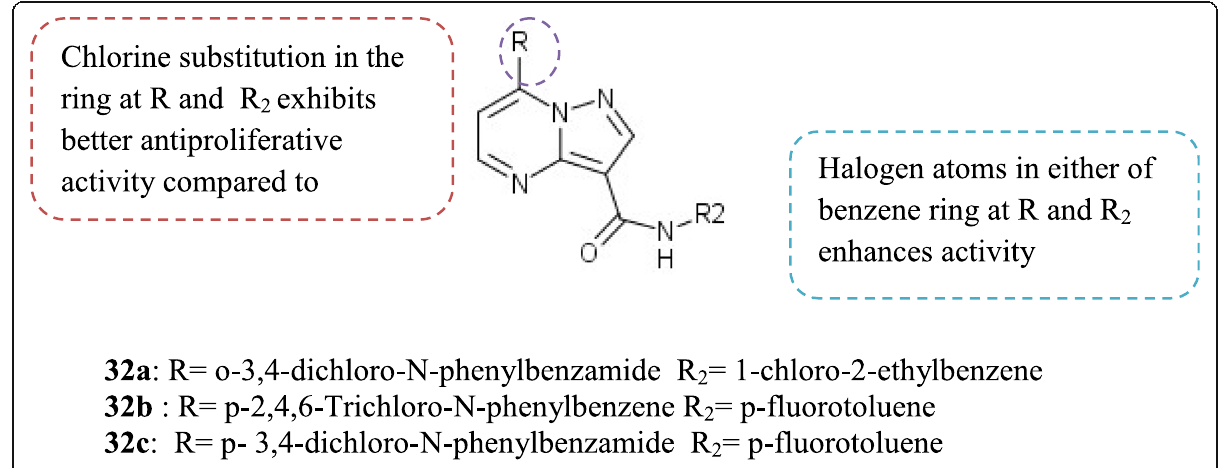
Fig. 14 Chemical structures and SAR studies of diamide substituted pyrazolo [1, 5-a] pyrimidine